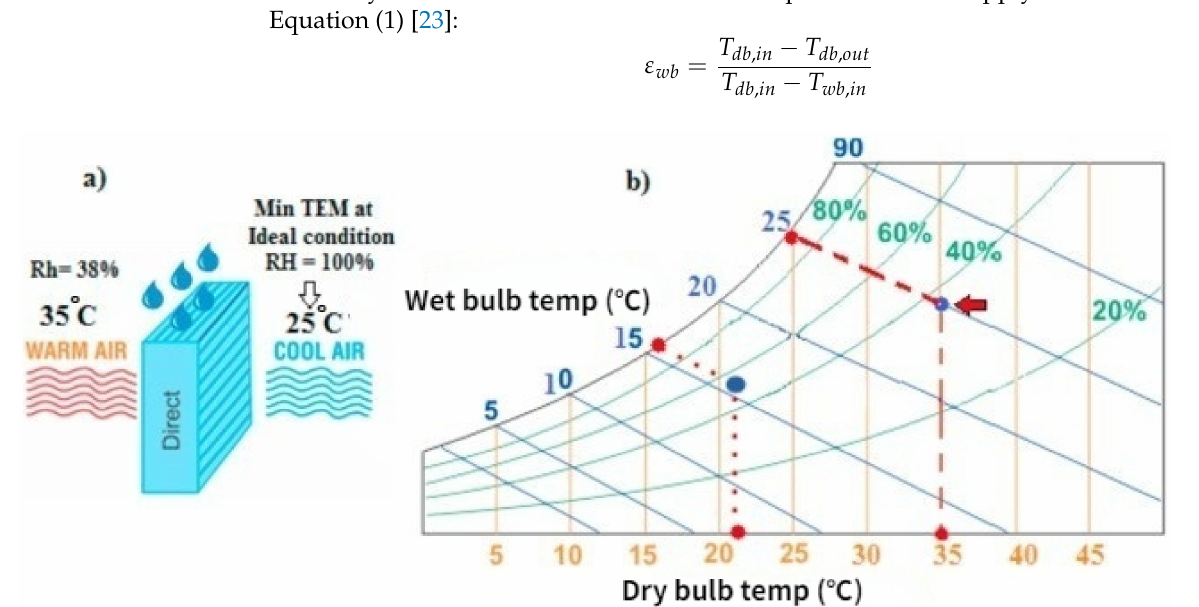
Figure 1. ( a ) System diagram of direct evaporative cooling (DEC); ( b ) DEC cooling process in a psychrometric chart